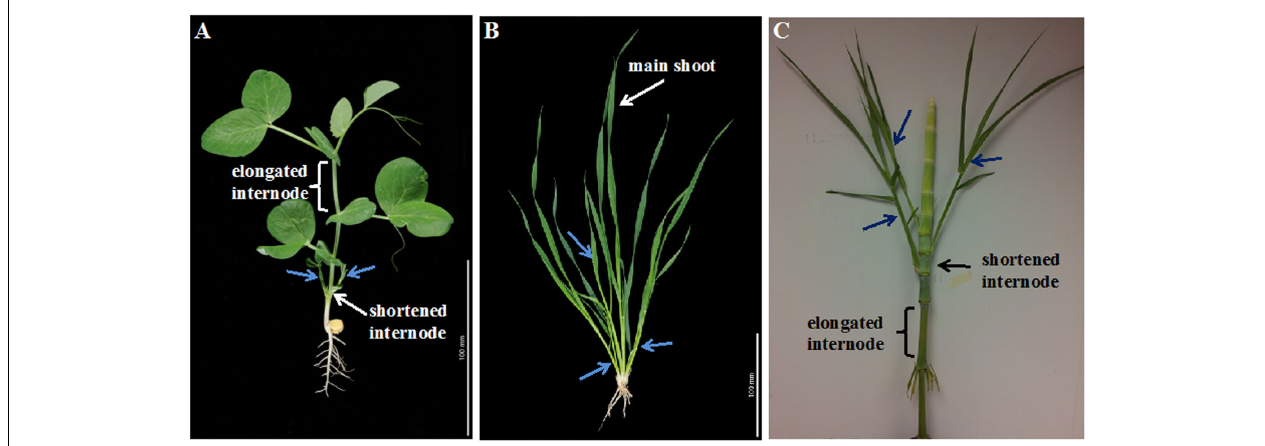
FIGURE 2 | Stem growth and shoot branching in eudicots and monocots. (A) In eudicots such as pea, stem internodes elongate during the vegetative phase and shoot branching is inhibited. However, pea plants develop branches (indicated by blue arrows) from lower nodes adiacent to shortened internodes. (B) In monocots such as wheat, internodes do not elongate during the vegetative phase and tillers (basal branches, indicated by blue arrows) develop from the shortened internodes at the base of the shoot. (C) When grown at high density enriched with shade signals from neighbor plants, internodes of monocots such as sorghum elongate and bud outgrowth is suppressed. When the density is reduced internode elongation is suppressed and branches (indicated by blue arrows)